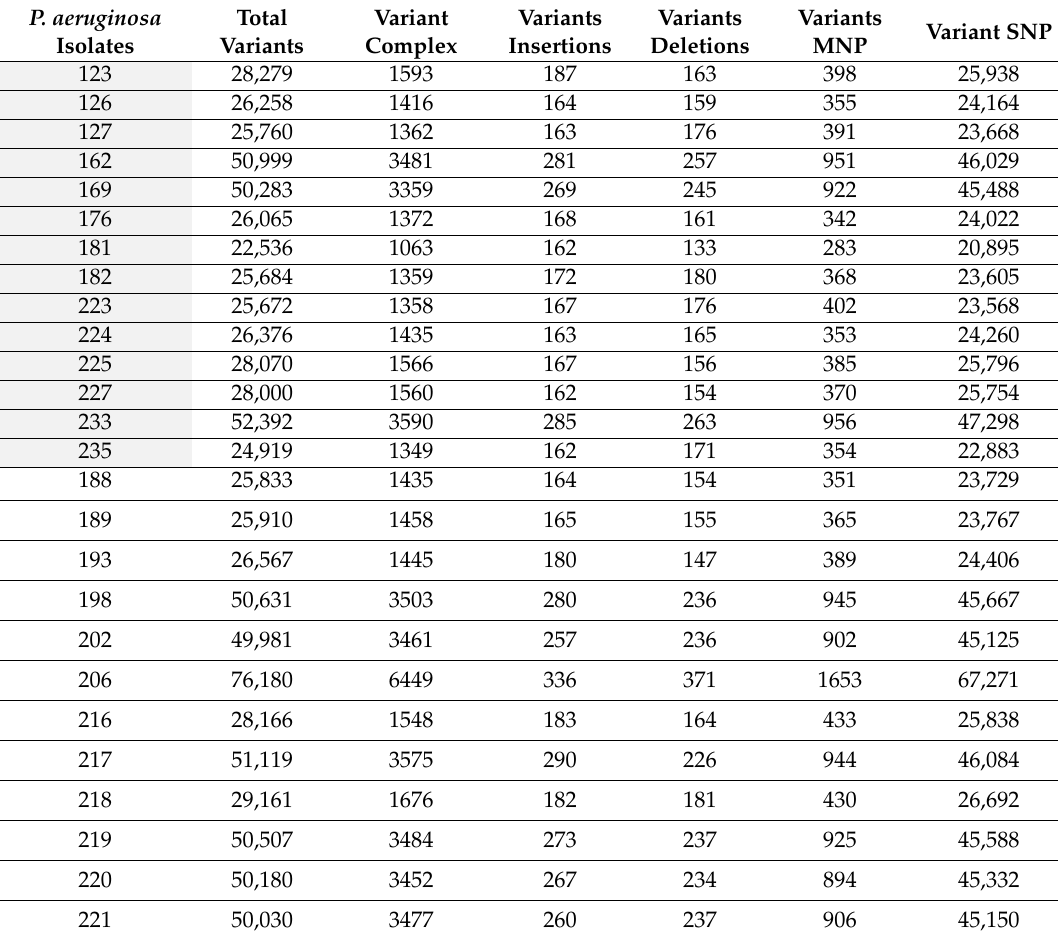
Table 3. Frequency of di ff erent types of variation in the genes of P. aeruginosa isolates. P.